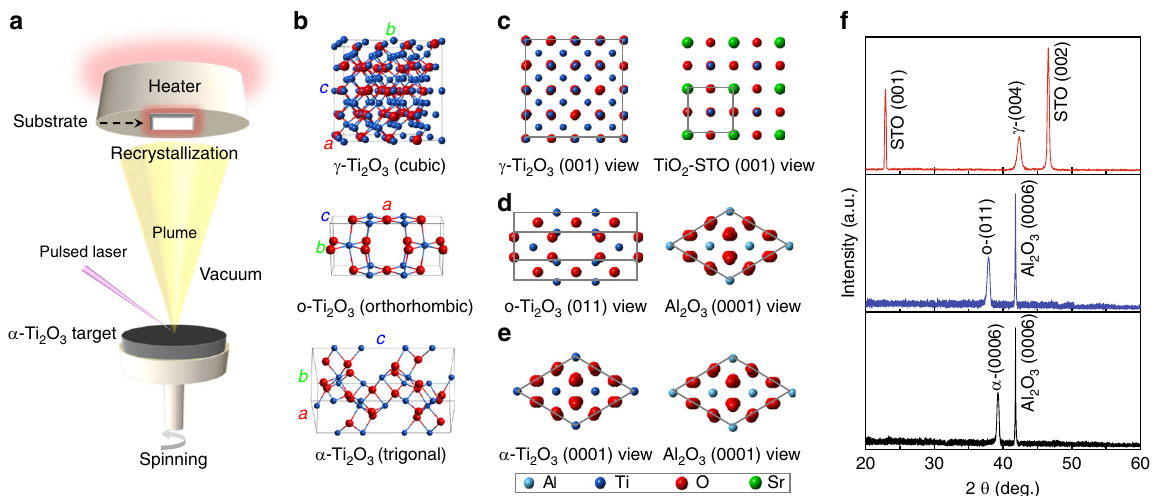
Fig. 1 Fabrication and structural characterizations of the Ti 2 O 3 polymorphs. a Schematic of the PLD chamber where Ti 2 O 3 polymorphs were fabricated using the same ( α -Ti 2 O 3 ) target. b Unit cells for γ -Ti 2 O 3 , o-Ti 2 O 3 , and α -Ti 2 O 3 polymorphs from top to bottom, respectively. c – e In-plane epitaxial relationships for γ -Ti 2 O 3 on STO, o-Ti 2 O 3 , and α -Ti 2 O 3 on Al 2 O 3 , respectively. TiO 2 – STO (001) view refers to view the TiO 2 -terminated STO (Supplementary Fig. 5) from the < 001 > direction. f HR-XRD patterns of Ti 2 O 3 polymorphs epitaxially stabilized on the single-crystal substrates. Source data are provided as a Source Data fi